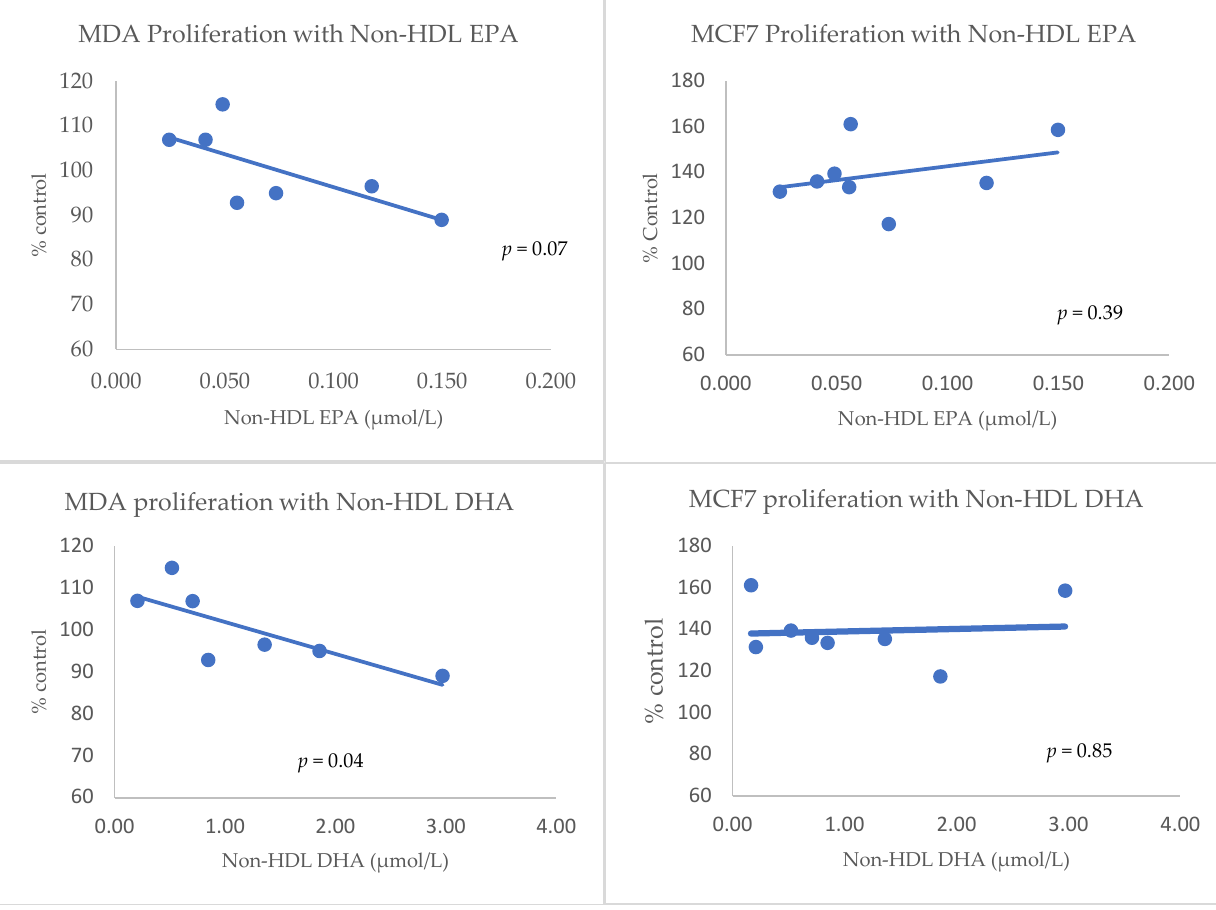
Figure 1. In vitro proliferation assay with different concentrations of Non-HDL EPA ( top ) and Non-HDL DHA ( bottom ) fractions by MTT assay on MDA-MB-231 cells and on MCF-7 cells. Expressed as % for control. HDL: high-density lipoprotein; EPA: eicosapentaenoic; DHA: docosahexaenoic.